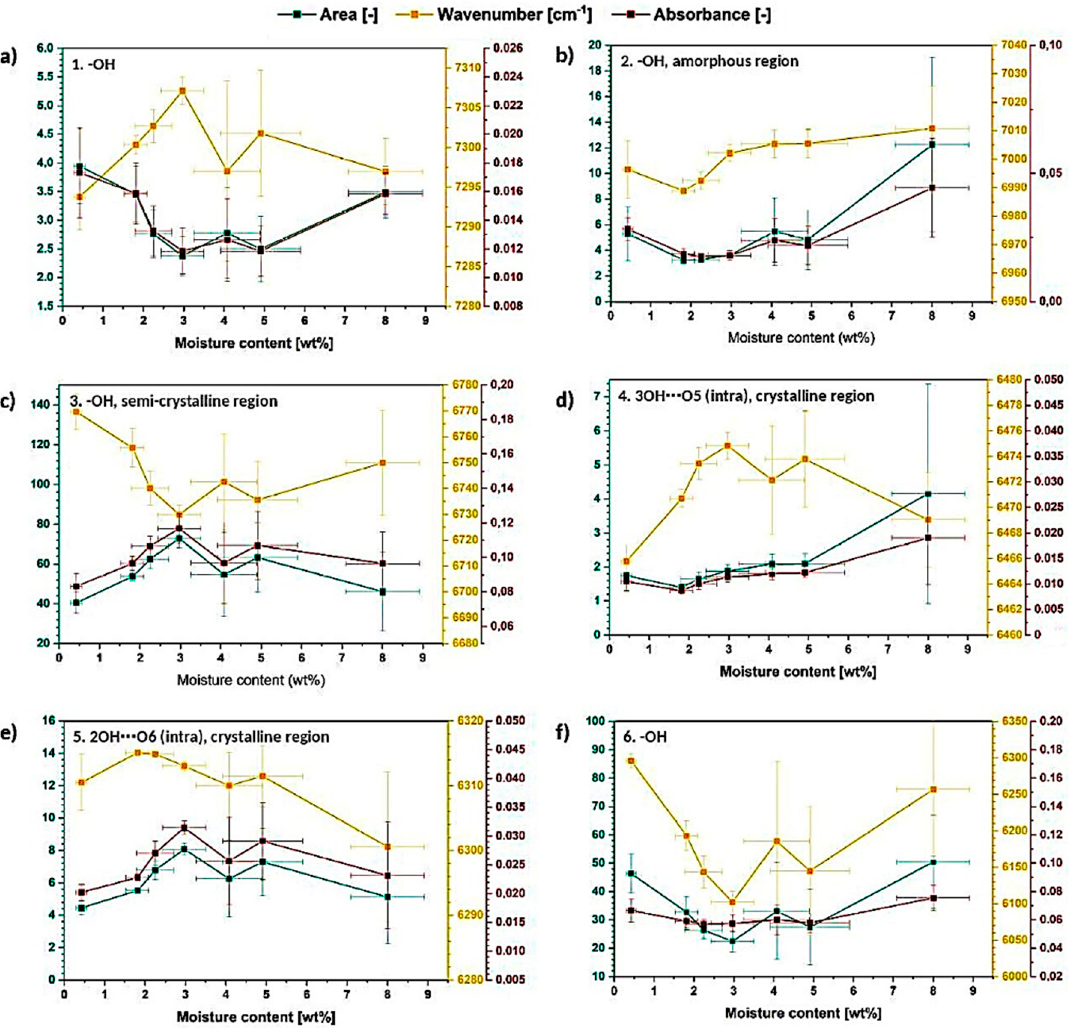
Figure 10. Graphs illustrating the changes in the deconvoluted peaks area, wavenumber and absorbance for the resolved signals: ( a ) − OH, ( b ) − OH and amorphous region, ( c ) − OH and semi- crystalline region, ( d ) 3OH ⋯ O5 and crystalline region, ( e ) 2OH ⋯ O6 and crystalline region, ( f ) −